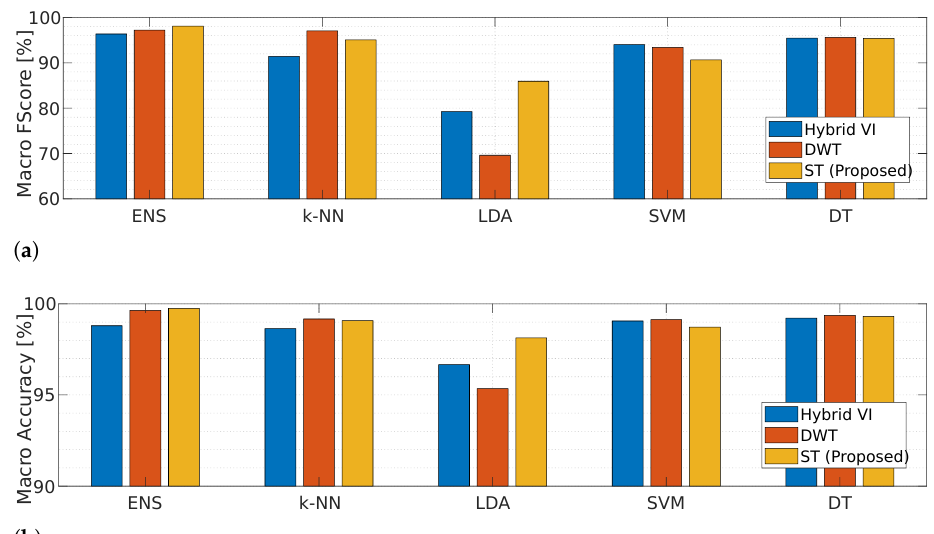
Figure 8. Average of best macro FScores and Accuracies for each classifier for PLAID dataset. ( a ) Average of best macro FScores for each classifier. ( b ) Average of best macro Accuracies for each